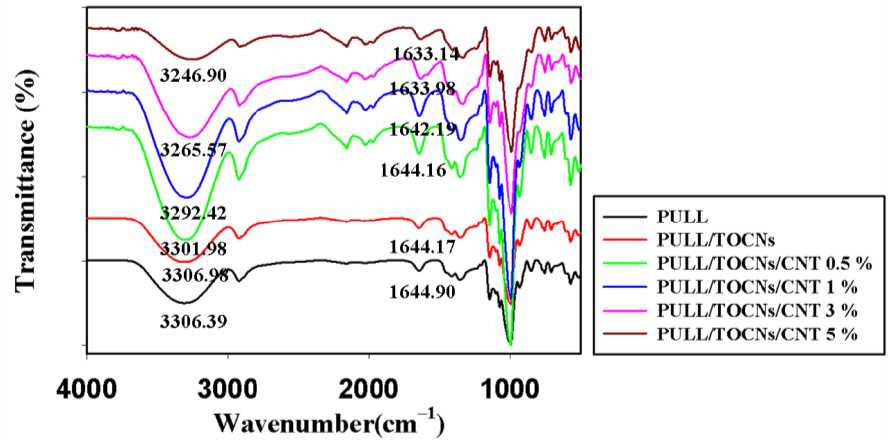
Figure 3. FT-IR data of neat PULL and PULL/TOCNs/CNT (0–5 wt.%) composite films.